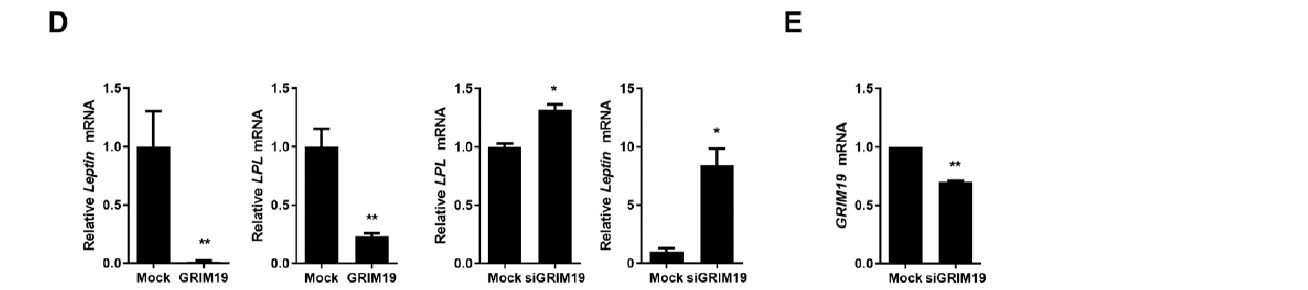
Figure 1. Genes associated with retinoid-interferon-induced mortality 19 (GRIM19) regulates the transcript levels of genes associated with white adipose tissue (WAT) and brown adipose tissue (BAT). Scale bar, 100 µ m. ( A ) Representative images of Oil Red O-stained 3T3-L1 cells. Mock and GRIM19-overexpressing 3T3-L1 cells were stained with Oil Red O. ( B , C ) Transcript levels of genes associated with WAT ( B ) and BAT ( C ) in 3T3-L1 cells expressing control plasmids (MOCK) and plasmids encoding GRIM19 (Grim19). ( D ) Transcript levels of leptin and lipoprotein lipase ( LPL ) in 3T3-L1 cells expressing control plasmids (MOCK), plasmids encoding GRIM19 (Grim19), or GRIM19-depleted siRNA (siGrim19). ( E ) GRIM19 mRNA levels were determined using real-time polymerase chain reaction. GAPDH was used as the internal control. Data are presented as the means ± standard deviations (SDs) of three independent experiments. * p < 0.05, ** p < 0.01, *** p < 0.001, and ns = not significant.